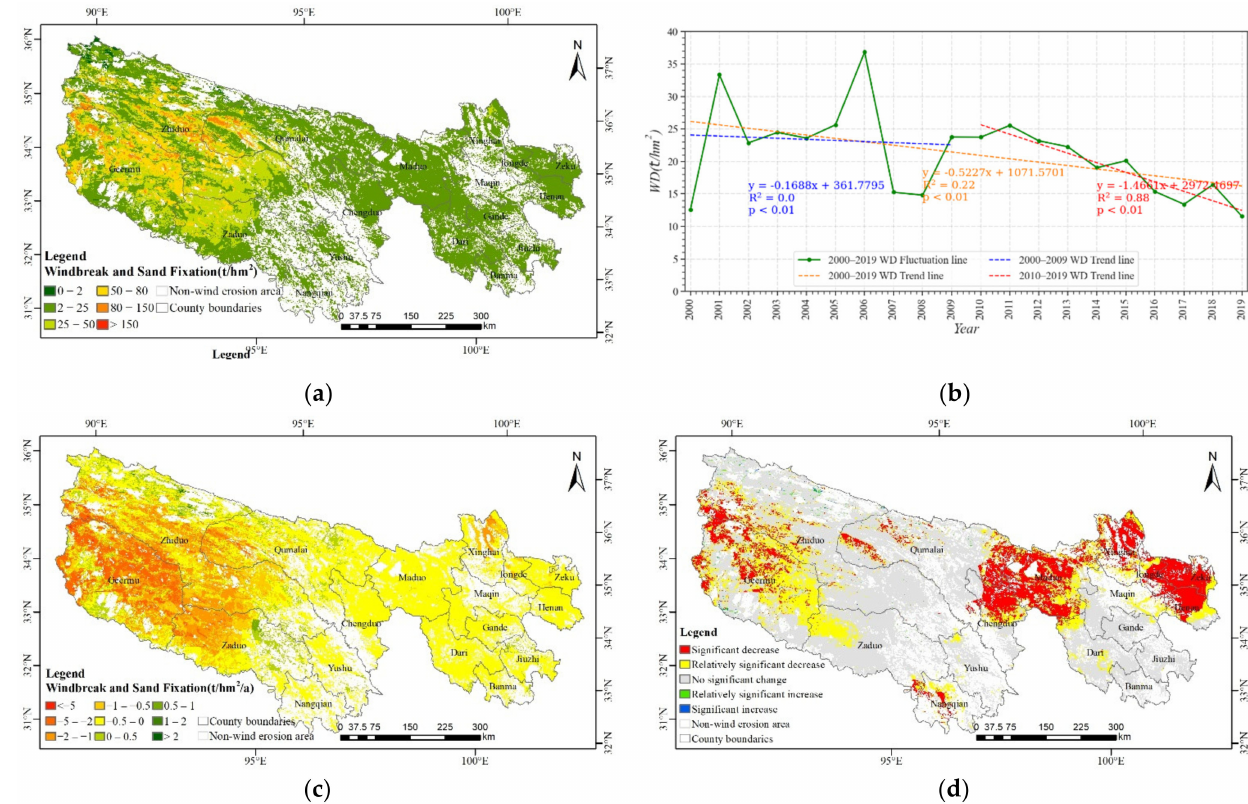
Figure 8. Spatial distribution of average annual windbreak and sand fixation ( a ), inter-annual changes ( b ), change trend ( c ), and significance ( d ) of ecosystems in the TRHR from 2000 to